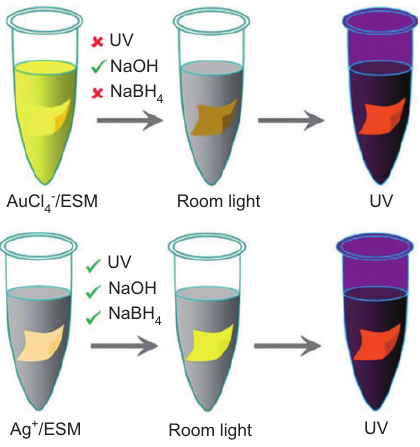
Figure 6 Schematic representation of an eggshell membrane (ESM)-based multimodal platform for the synthesis of fluorescent AuNC and AgNC. From Ref. [85]